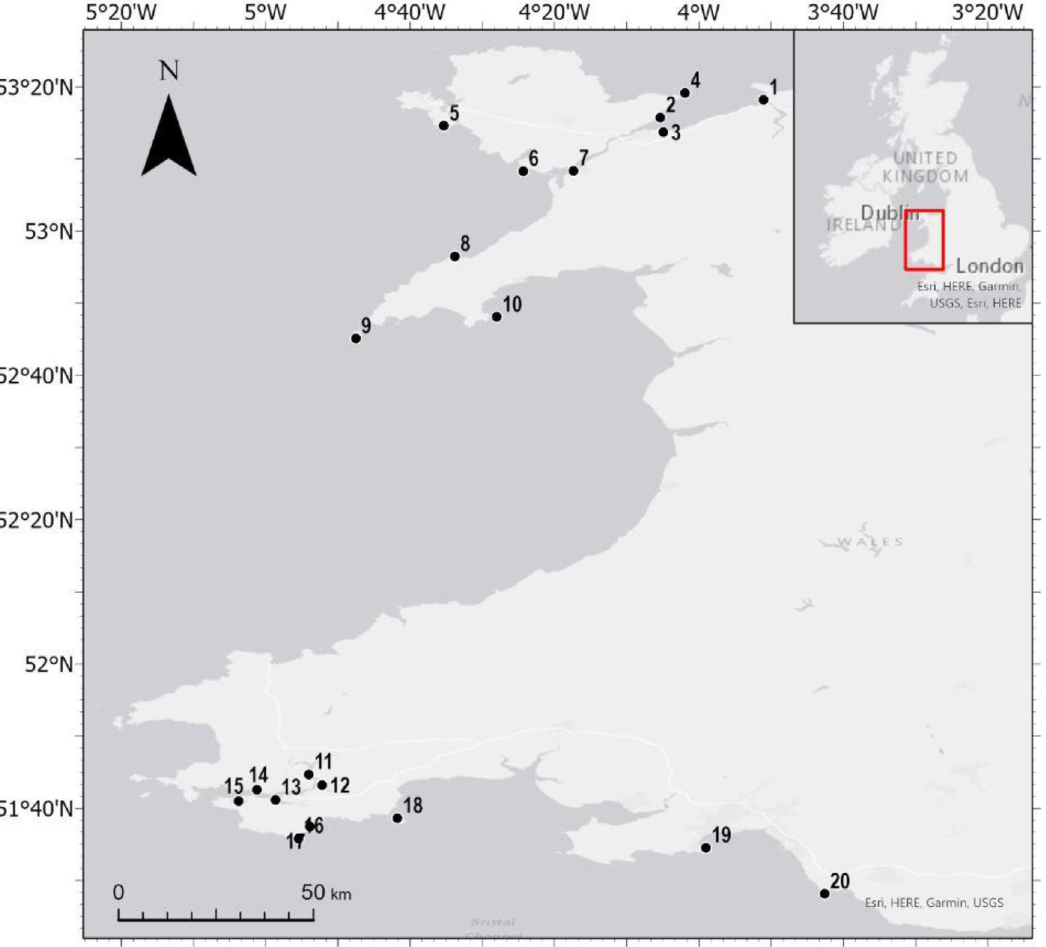
Fig. 1. Map of known historical native oyster culture sites in Wales- Conwy (1), Beaumaris (2), Ogwen River (3), Puf fi n Island (4), Rhoscolyn (5), Llanddwyn Island (6), Caernarfon (7), Porthdinllaen (8), Bardsey Island (9), Saint Tudwals Islands (10), Llangwm (11), Lawrenny (12), Pennar (13), Castle Pill (14), Angle (15), Saint Govan ’ s Head (16), Stackpole (17), Caldey Island (18), The Mumbles (19), Porthcrawl (20). Esri Inc. (2021). ArcGIS Pro (Version